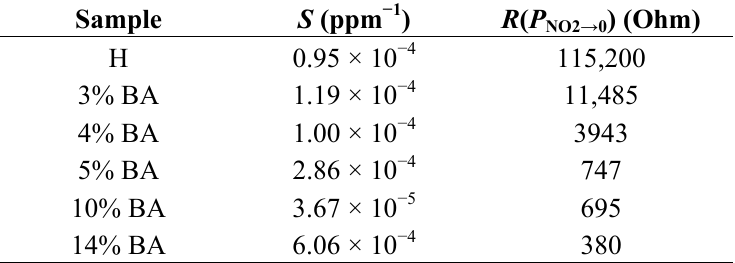
Table 4. Sensitivity ( S ) of hematite and various barium-doped hematite pellets measured at 200